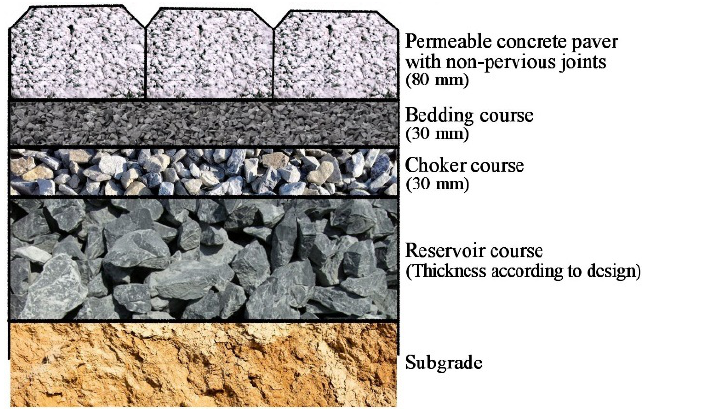
Figure 1. Permeable pavement model used in the